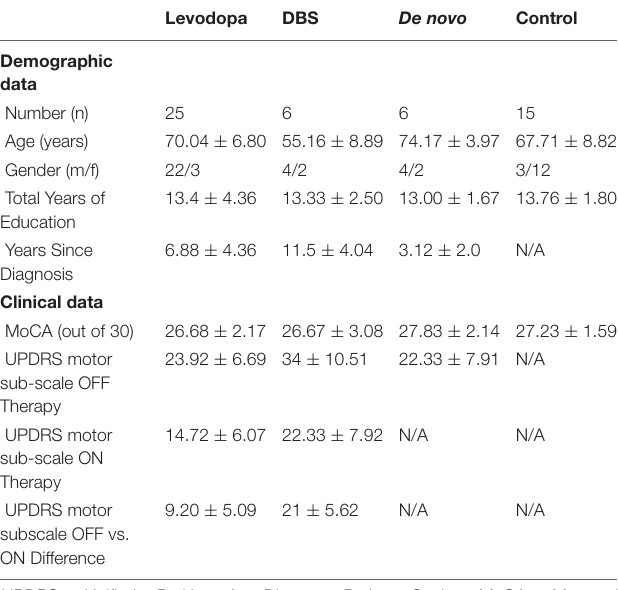
TABLE 1 | Summary of Demographic and Clinical Data for Tested PD